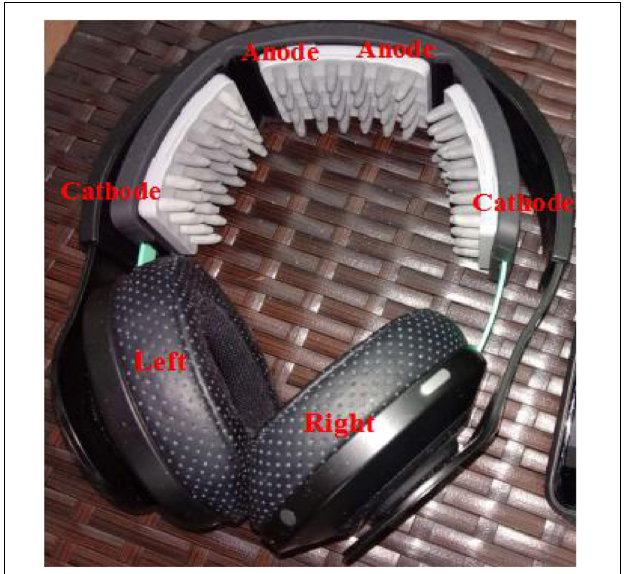
FIGURE 1 | The experimental setup for tDCS (Halo Sport) and the placement of the electrodes (Yang et al., 2018; Codella et al.,